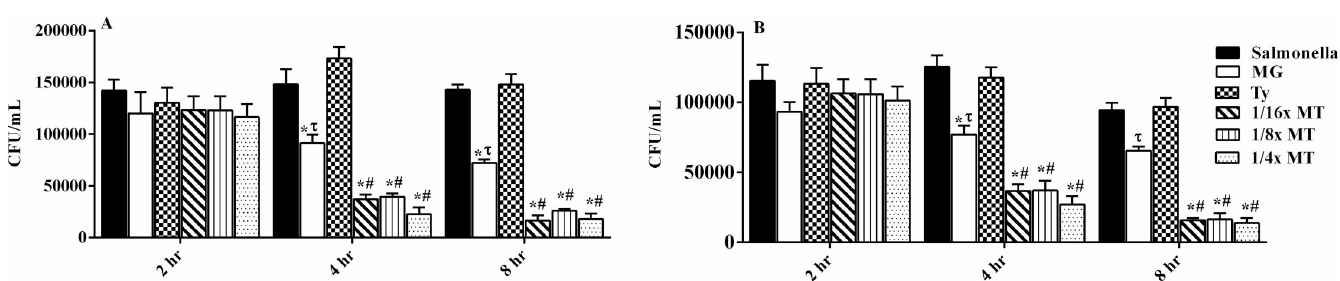
Fig 8. Efficacy of methyl gallate (MG), tylosin (Ty) and various concentrations of their combination (MT) on the intracellular killing of S . Typhimurium ATCC 14028 (A) and S . Typhimurium LVPP-STI15 (B) in macrophages at 2, 4 and 8 h post-treatment and infection. Cell: non-infected and non-treated control. Salmonella : S . Typhimurium infected, but non-treated cells. Values represent mean ± SEM of six independent experiments. MG = 32 μ g/mL; Ty = 64 μ g/mL; 1 / 16 × MT = 8 μ g/mL MG and 16 μ g/mL Ty; 1 / 8 × MT = 16 μ g/mL MG and 32 μ g/mL Ty; and ¼× MT = 32 μ g/mL MG and 64 μ g/mL Ty. � P < 0.05 compared to infected, but non-treated cells; τ P < 0.05 compared to Ty; π P < 0.05 compared to MG; and # P < 0.05 compared to both MG and Ty.